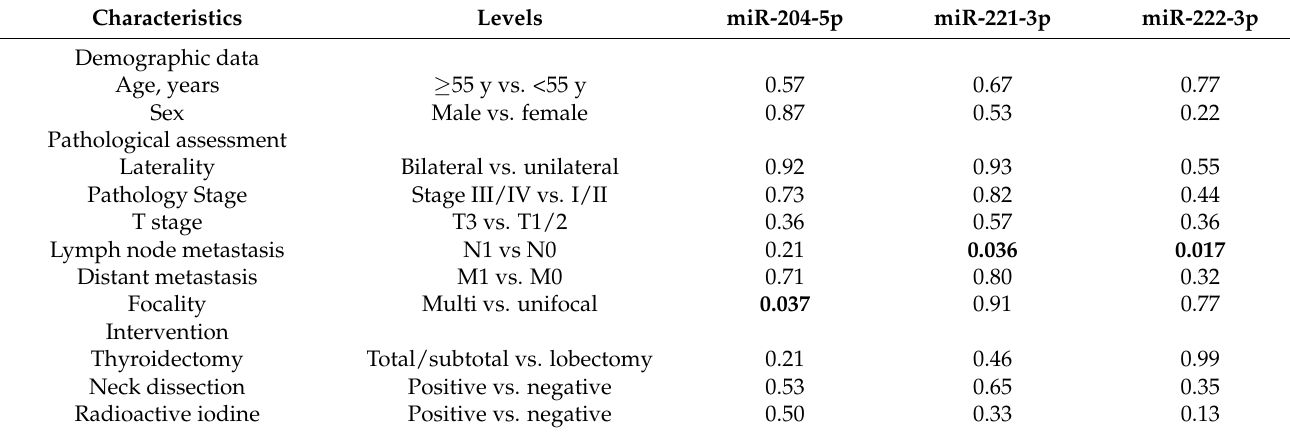
Table 3. Association of microRNA expression levels with demographic and clinicopathological characteristics (N = 68).